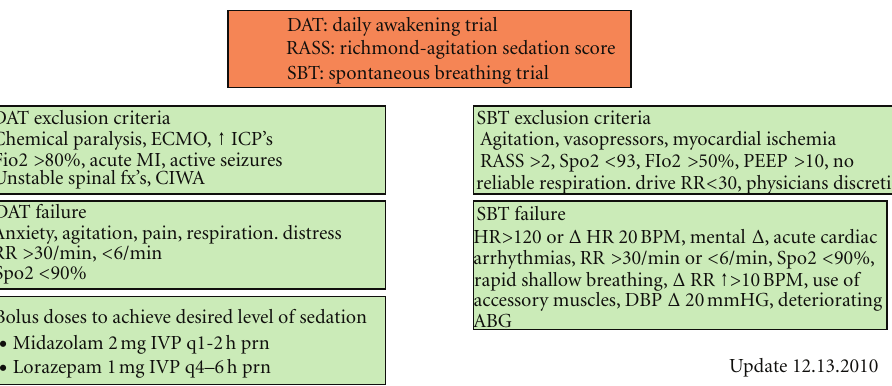
Figure 1: Daily awakening